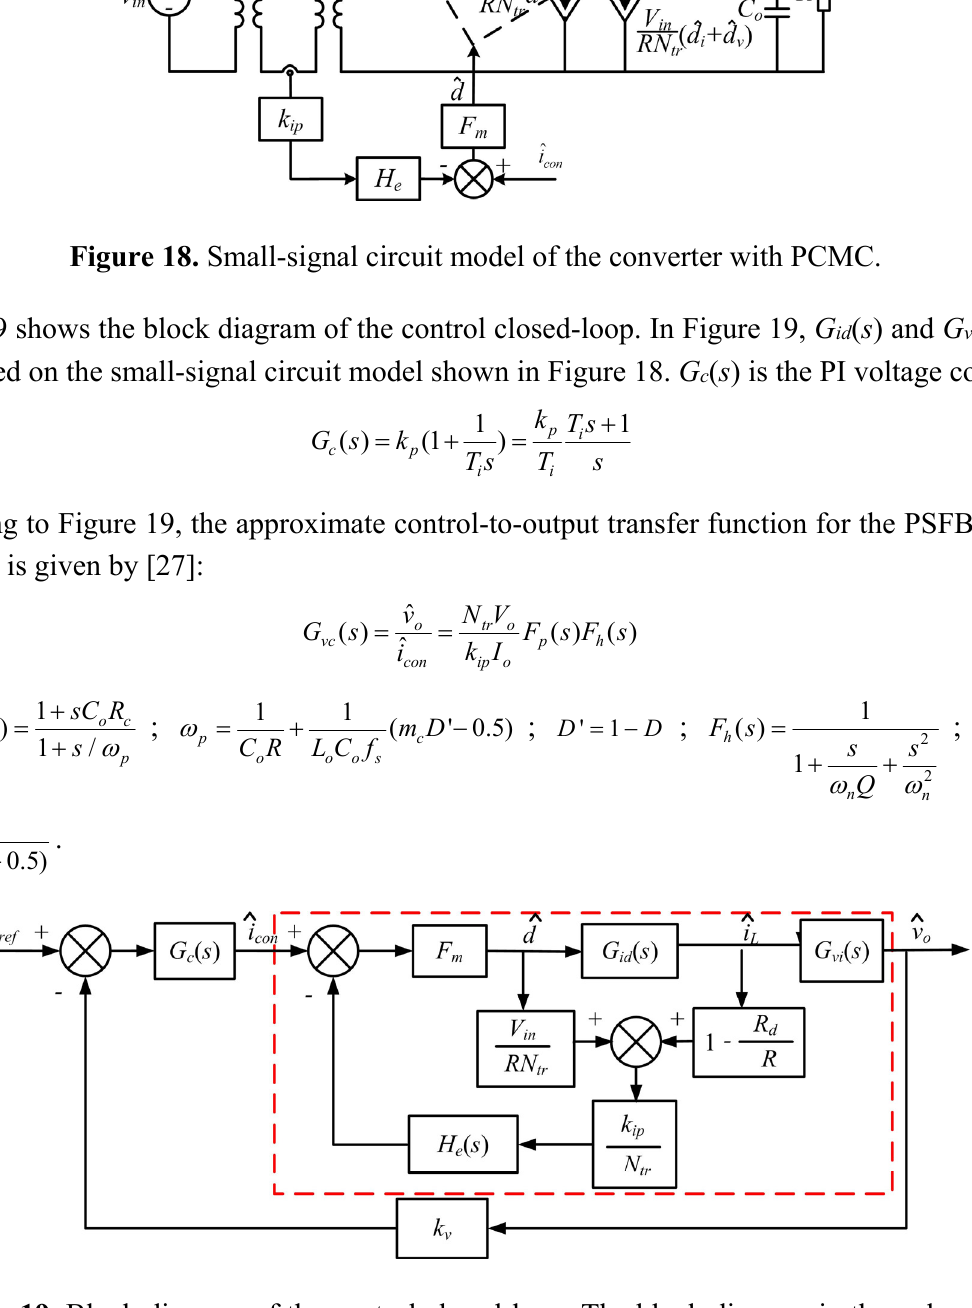
Figure 19. Block diagram of the control closed-loop. The block diagram in the red outline represents control-to-output transfer